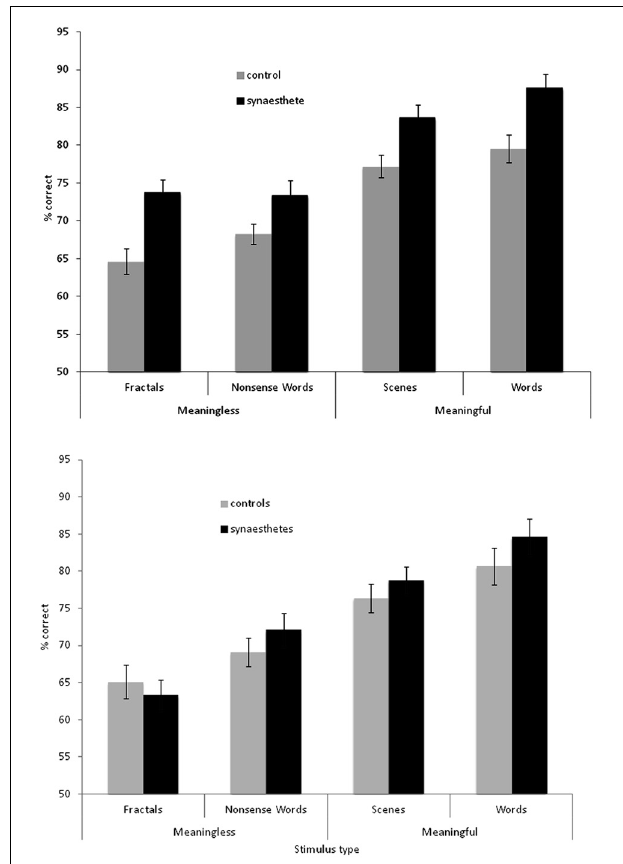
FIGURE 2 | Recognition memory accuracy (% correct) for synaesthetes and controls for different classes of stimuli. Top graph: grapheme-color synaesthetes. Bottom graph: lexical-gustatory synaesthetes. Error bars show ± 1 SEM.